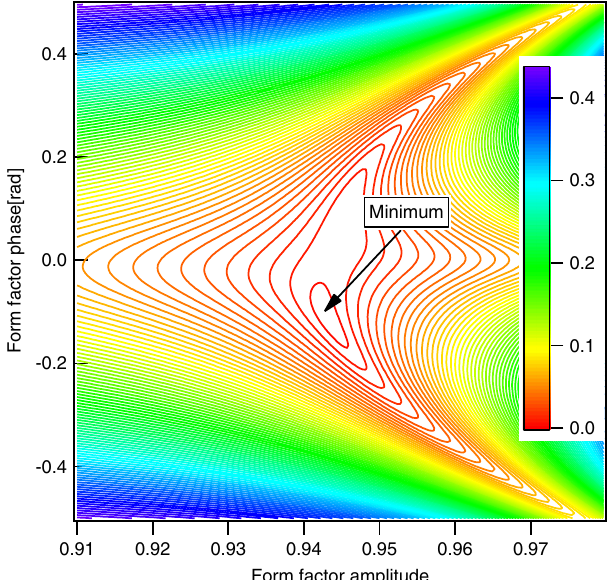
FIG. 12. Contour plot of the penalty function g for R 2 . 017 M Ω and Δ f ¼ − 28 . 43 kHz.